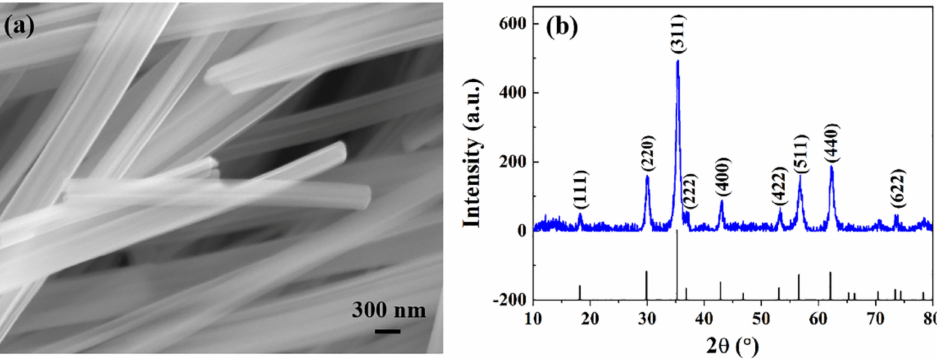
Figure 1. ( a , b ) SEM image and XRD spectrum of the MnZn ferrite homogeneous